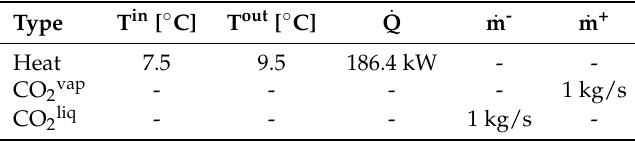
Table A15 for a mass flow of CO 2 of 1 kg/s. Table A15. Streams for central plant HE (summer).